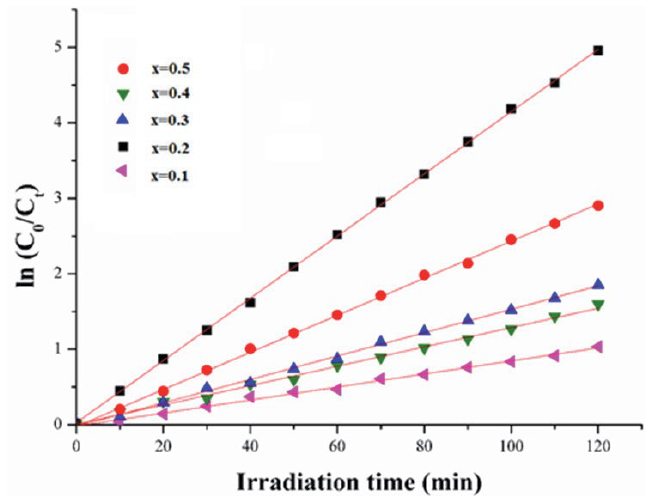
Fig. 7. Variation of ln(C 0 /C) vs. irradiation time under the visible light on the Cd x Zn 1-x O nanocomposites.